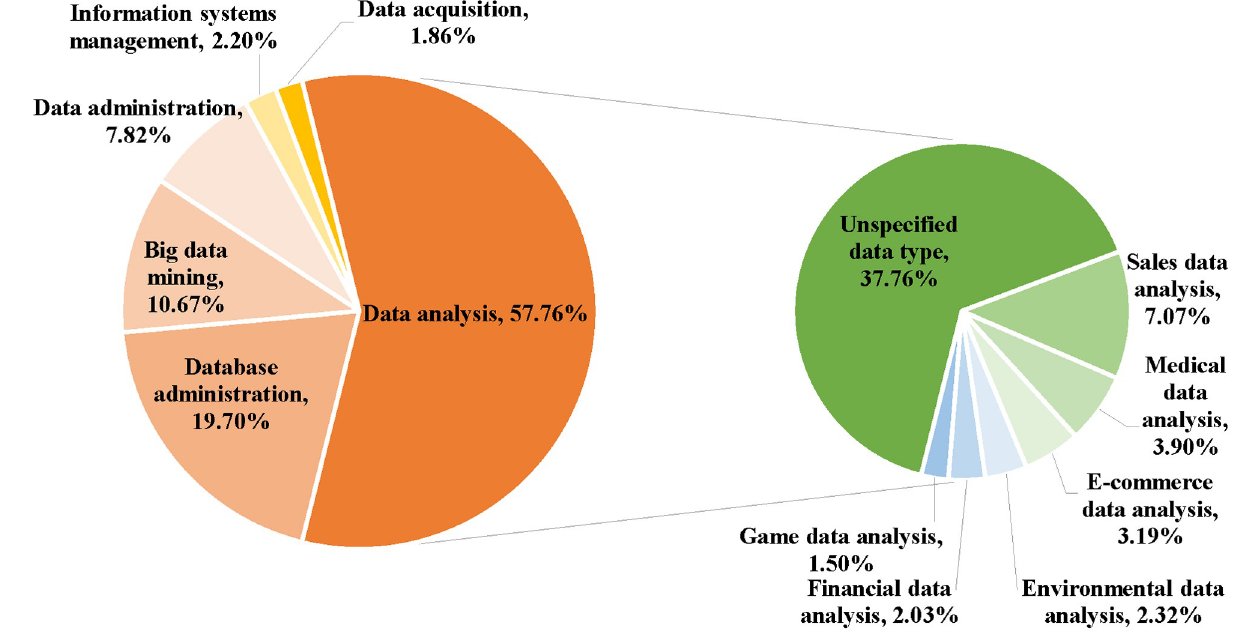
Fig 4. Categories of positions and their proportions.